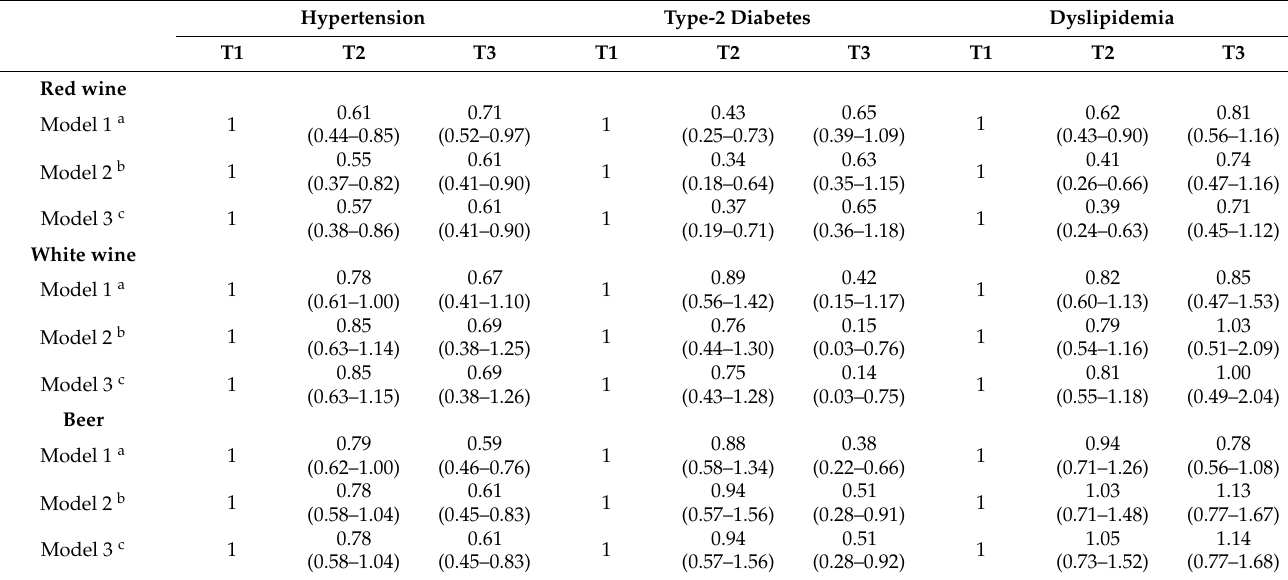
Table 6. Association between intake of alcoholic beverages containing polyphenols and metabolic outcomes in the study